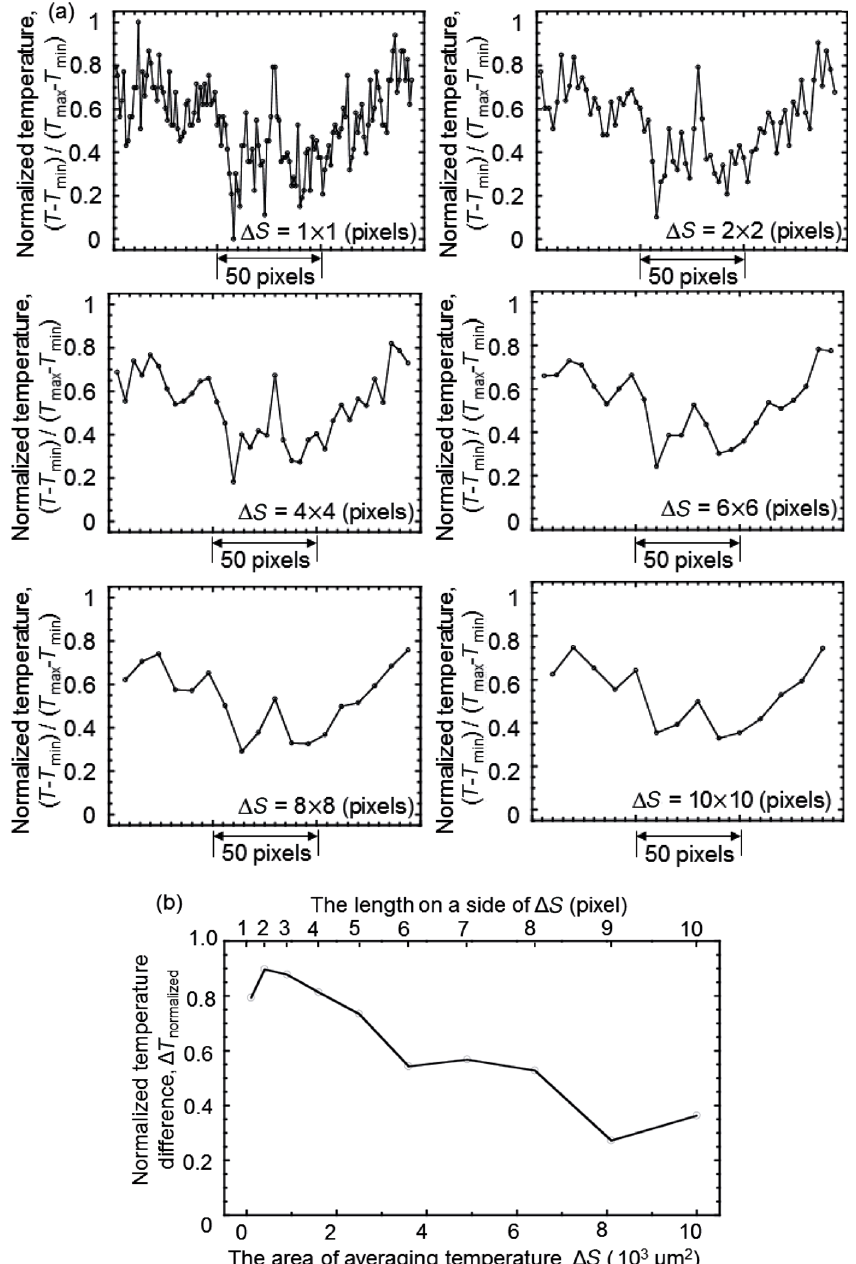
Fig. 7 Example of data processing: (a) relationship between normalized temperature and area of averaging temperature, and (b) normalized temperature difference between crack and low temperature